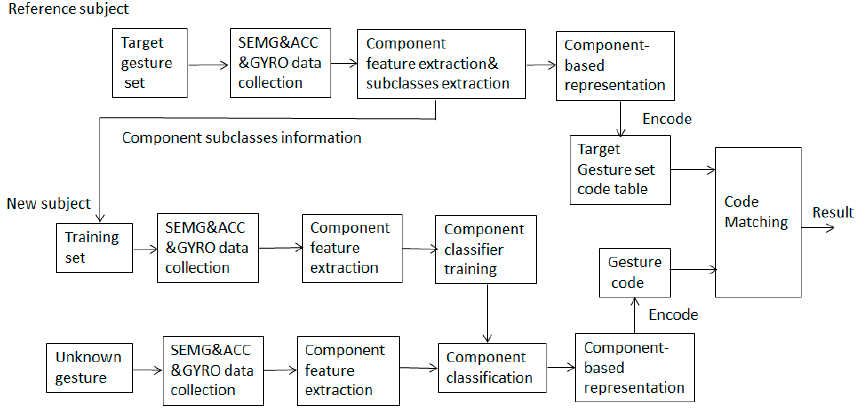
Figure 1. The flow diagram of the proposed SLR framework.